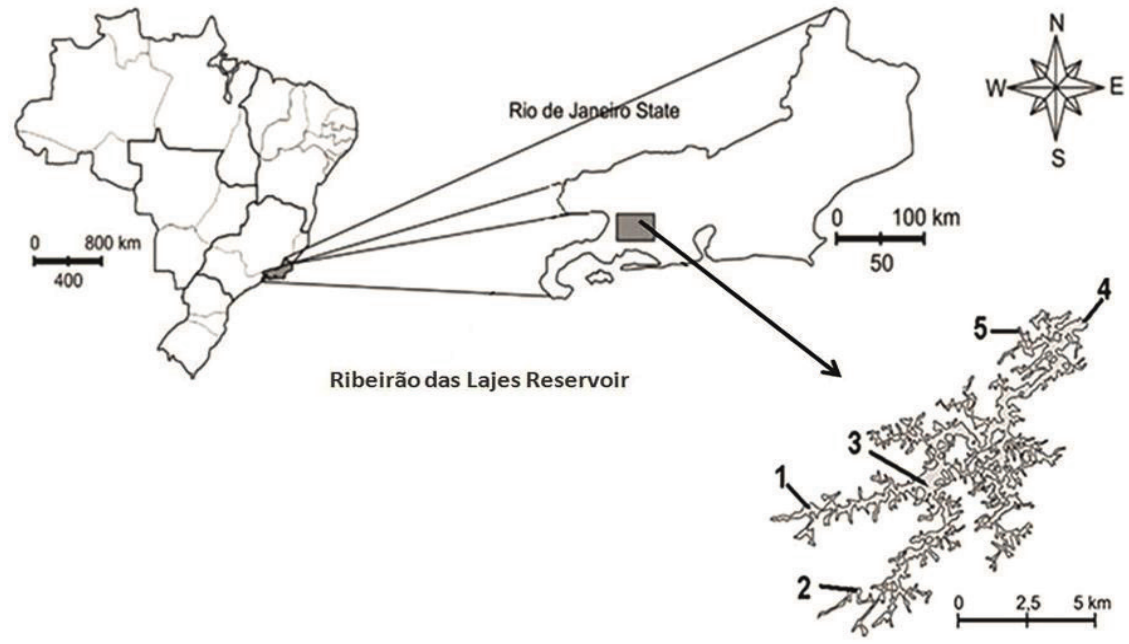
Figure 1 - Ribeirão das Lajes Reservoir, Rio de Janeiro, showing the position of the five sampling